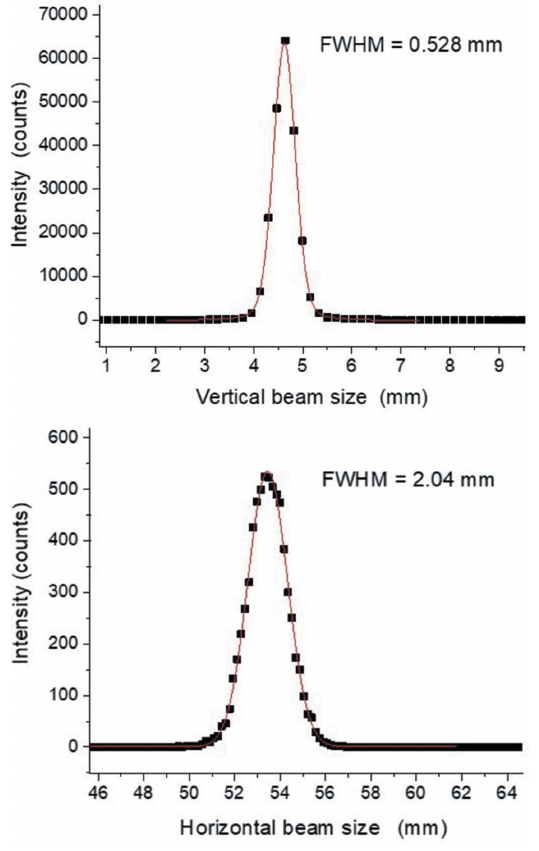
Figure 5 Vertical and horizontal focused beam profiles at the detector location.